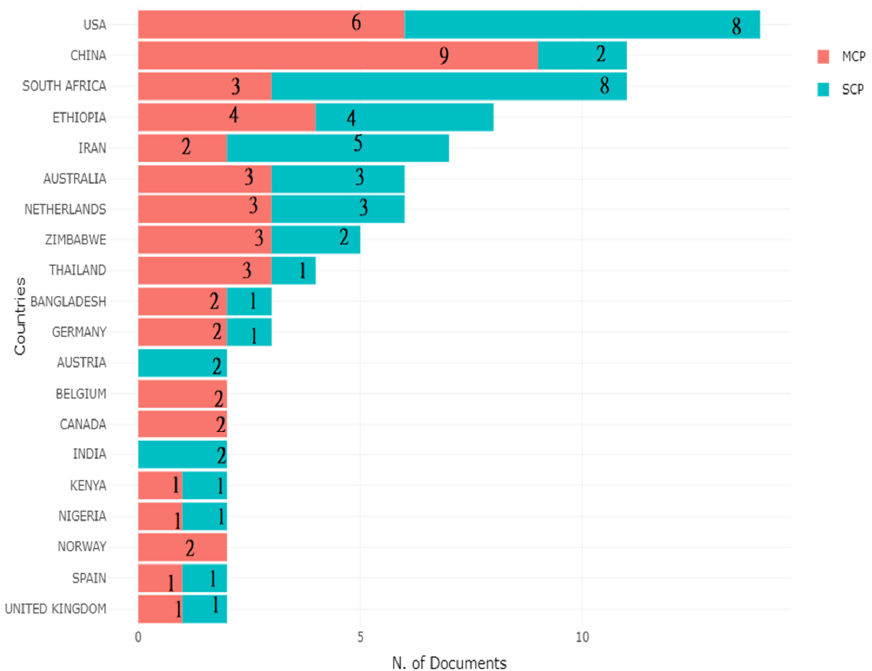
Figure 3. Top 20 most productive nations in PASSFDR documents indexed in Scopus (2011–2020). MCP: Multiple country production, SCP: Single country production. MCP: Multiple country production, SCP: Single country Table 4. Top 20 most productive nations by corresponding authors in the PASSFDR documents indexed in Scopus (2011–2020).